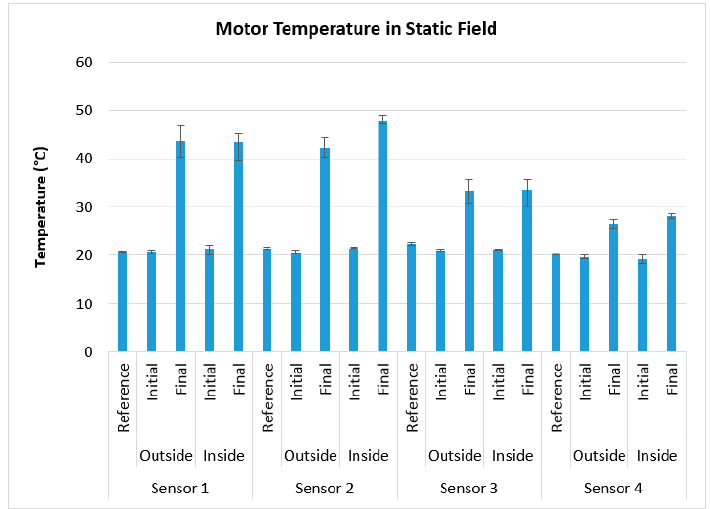
Figure 5. Motor temperature increase in static field, when the scanner was off.